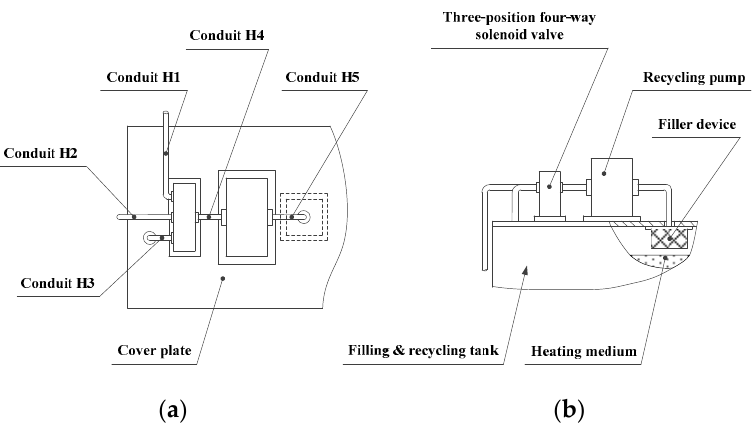
Figure 8. Recycling device. ( a ) Top view; ( b ) front view.